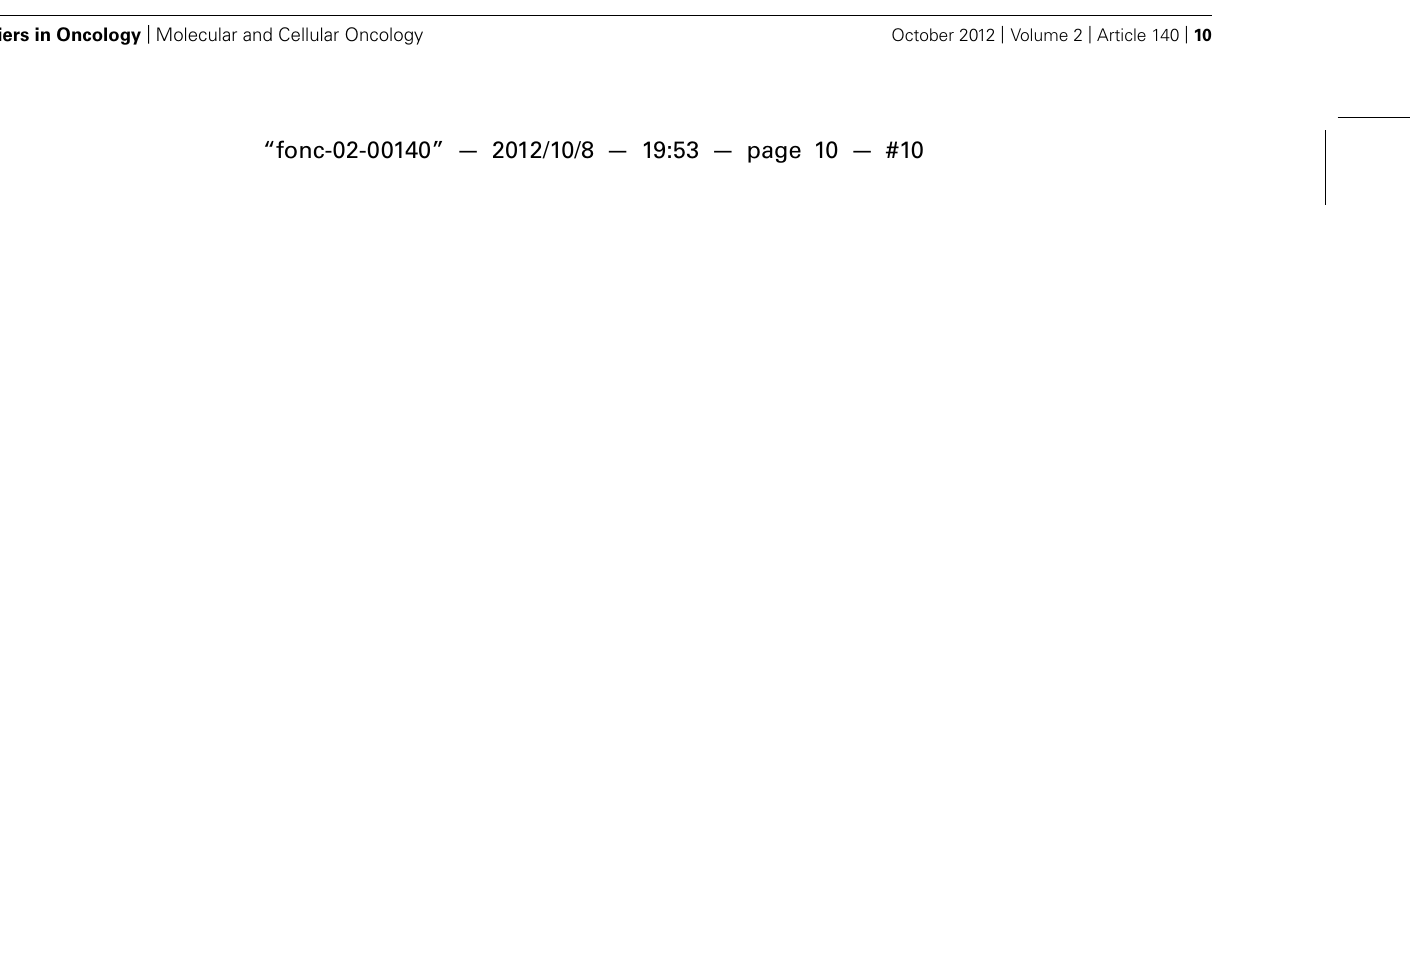
Frontiers in Oncology | Molecular and Cellular